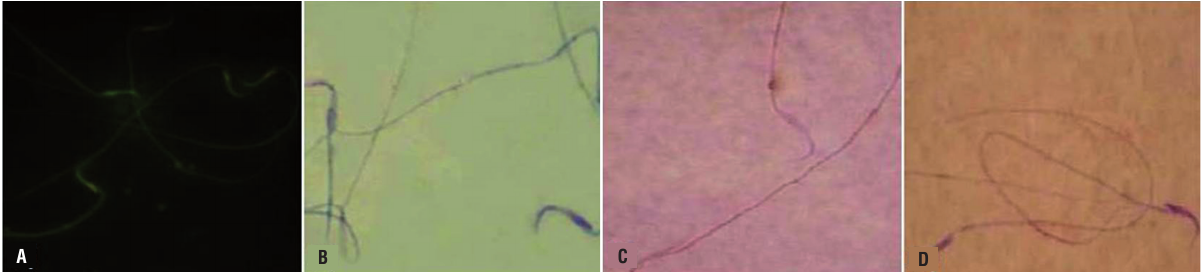
Figure 9 - Representative profile of sperms in different staining techniques. (A) Acridine-orange staining for sperm DNA integrity: light green stained sperm is representing sperm cell with double strand DNA and the sperms with damaged DNA are presented with bright red stained nucleus; (B) Aniline-blue staining for chromatin condensation: the sperm with condensed chromatin is presented with light stained nucleus and the sperm with dark stained nucleus is representing de-condensed chromatin; (C); and (D) Eosin- nigrosin staining for sperm viability: live sperms are presented with colorless cytoplasm in figure (C) and the dead sperms are represented darkly stained cytoplasm in figure